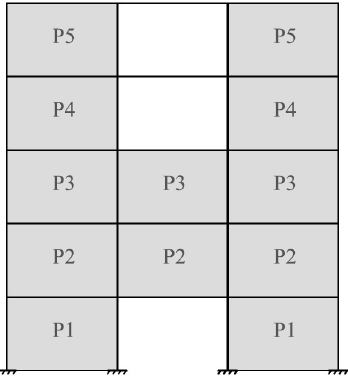
FW*: steel frame weight; PW: steel plate weight; TW: total weight. The units of weight and thickness of SPSWs are kN and mm; respectively.